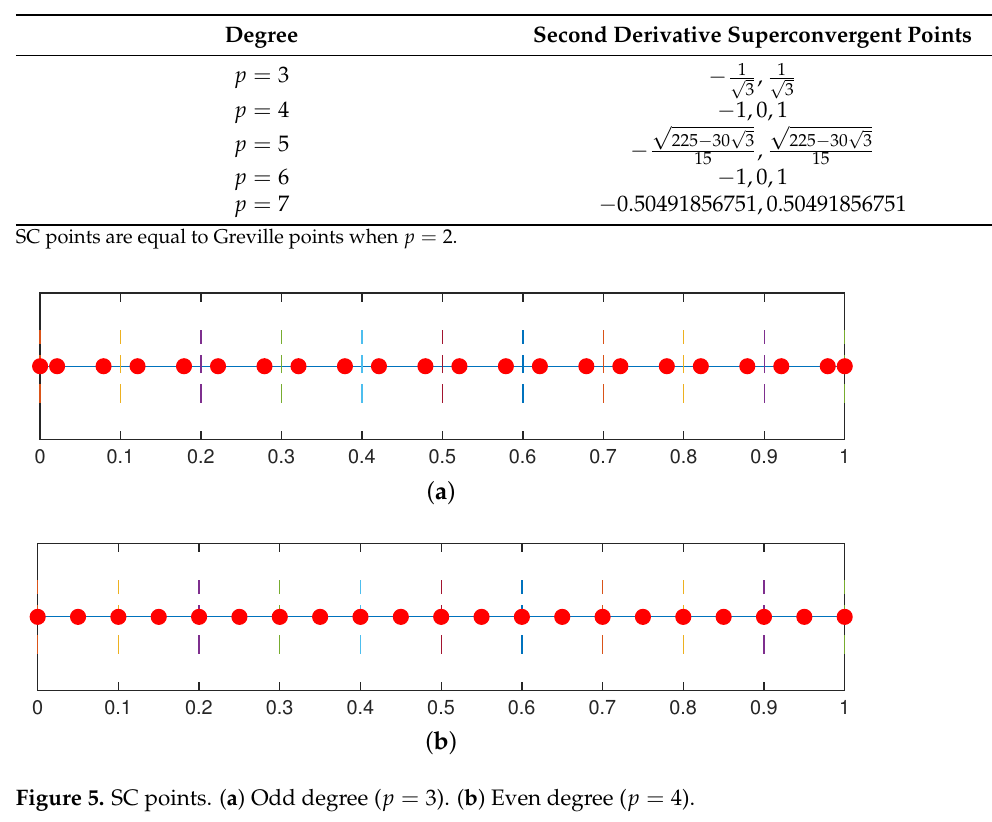
Table 1. Superconvergent points in the reference interval [ − 1,1 ] [28].